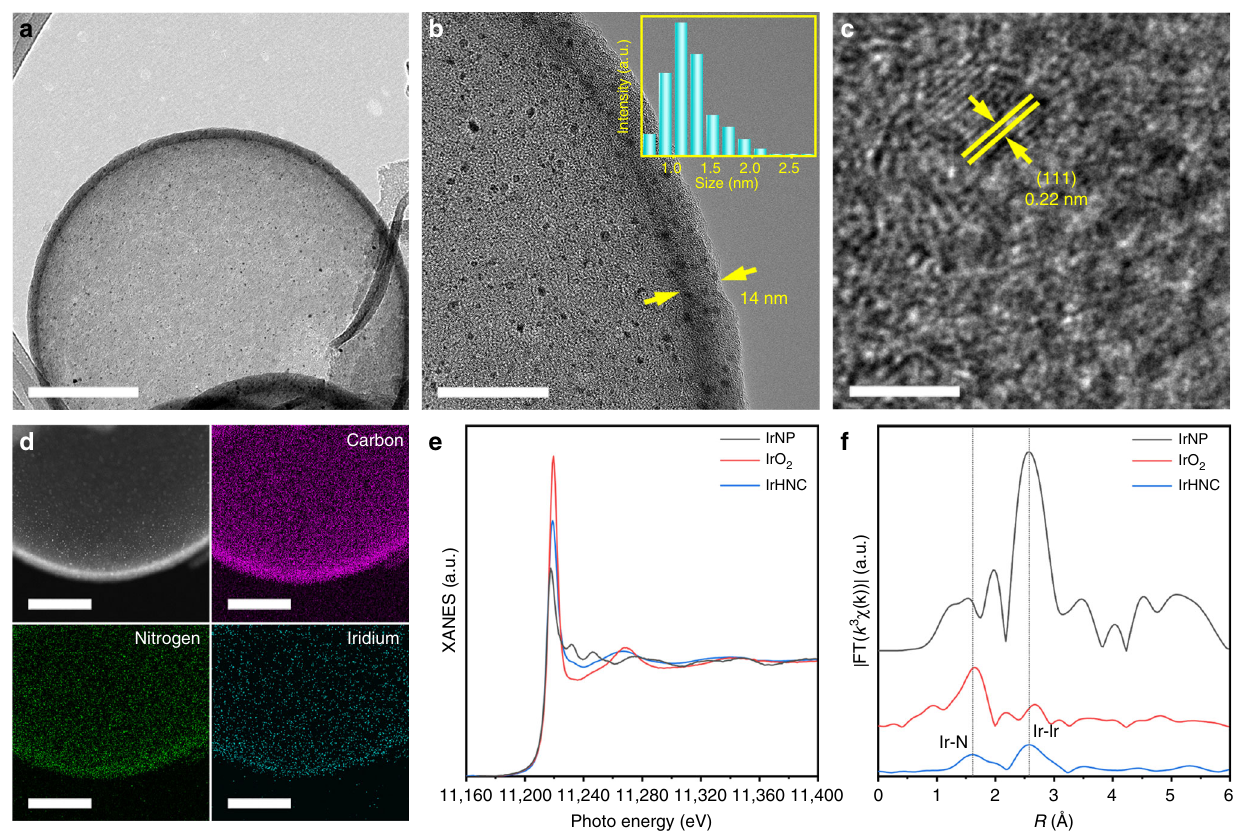
Fig. 4 Structural characterization of IrHNC. a , b Low-resolution TEM images of IrHNC. Inset is the corresponding particle size distribution of the Ir nanoparticles. c High-resolution TEM image of IrHNC. d Elemental mapping (purple: carbon, green: nitrogen, cyanic blue: iridium). e Ir L III -edge XANES spectra of IrNP, IrO 2 , and IrHNC, respectively. f Fourier transform (FT) of the Ir L III -edge EXAFS spectra of IrNP, IrO 2 , and IrHNC, respectively. Scale bars: a 200 nm, b 40 nm, c 3 nm, d 100